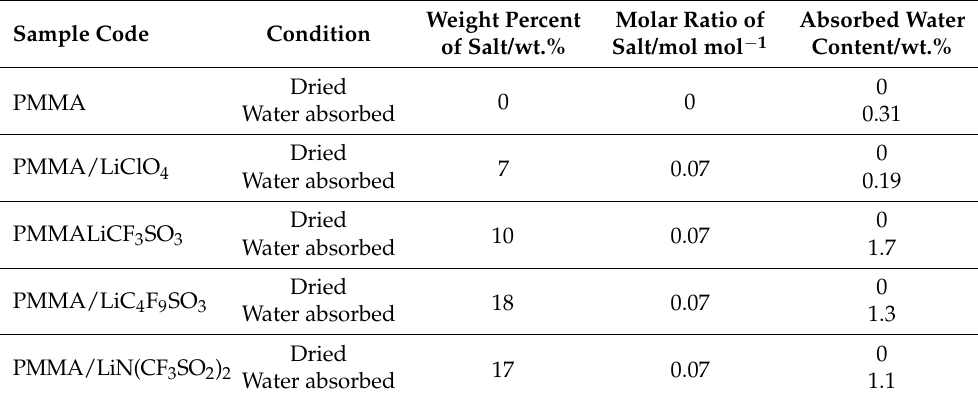
Table 1. The sample code, salt concentrations (weight and molar concentrations), and moisture concentrations of the dried and the equilibrium saturated moisture contents of the PMMA sheets doped with salts. Sample Code Condition